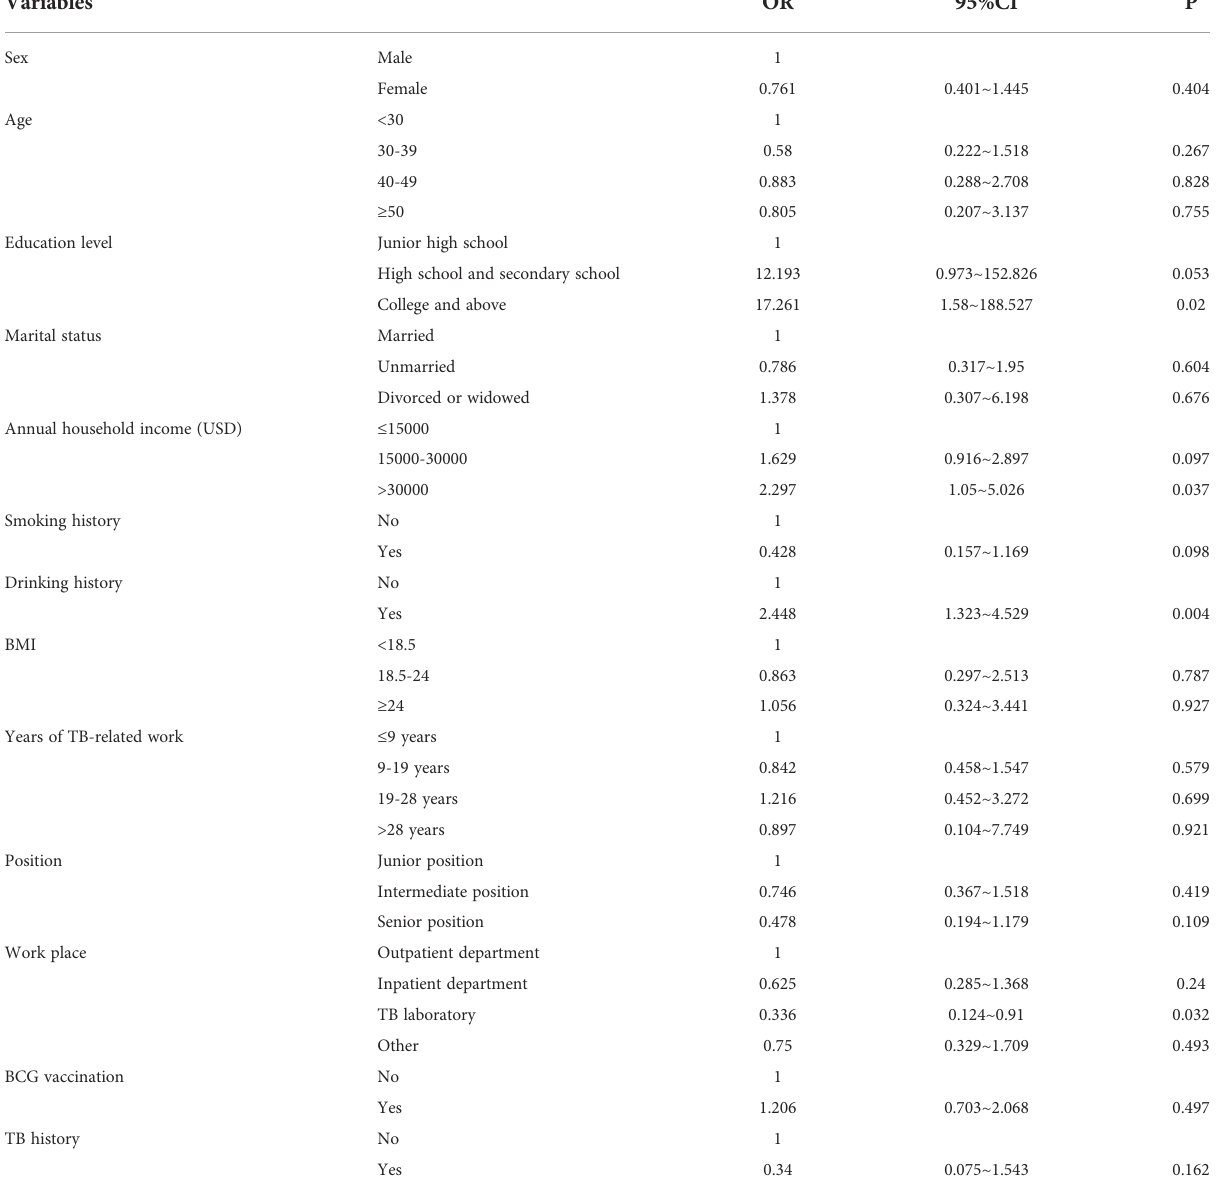
TABLE 3 Multivariate regression analysis of the in fl uencing factors of TB-related health workers willingness to take prophylaxis medicine.